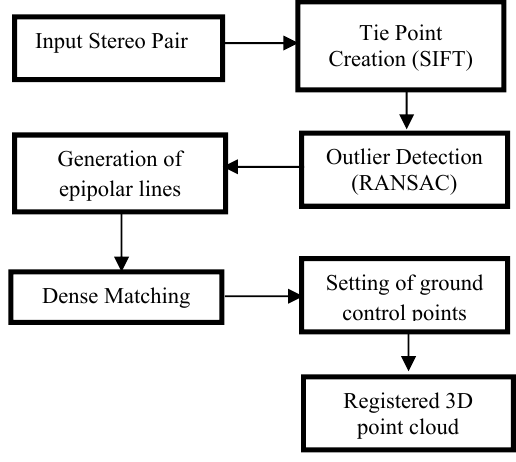
Figure-5 Flowchart of PIXEL-PHOTO